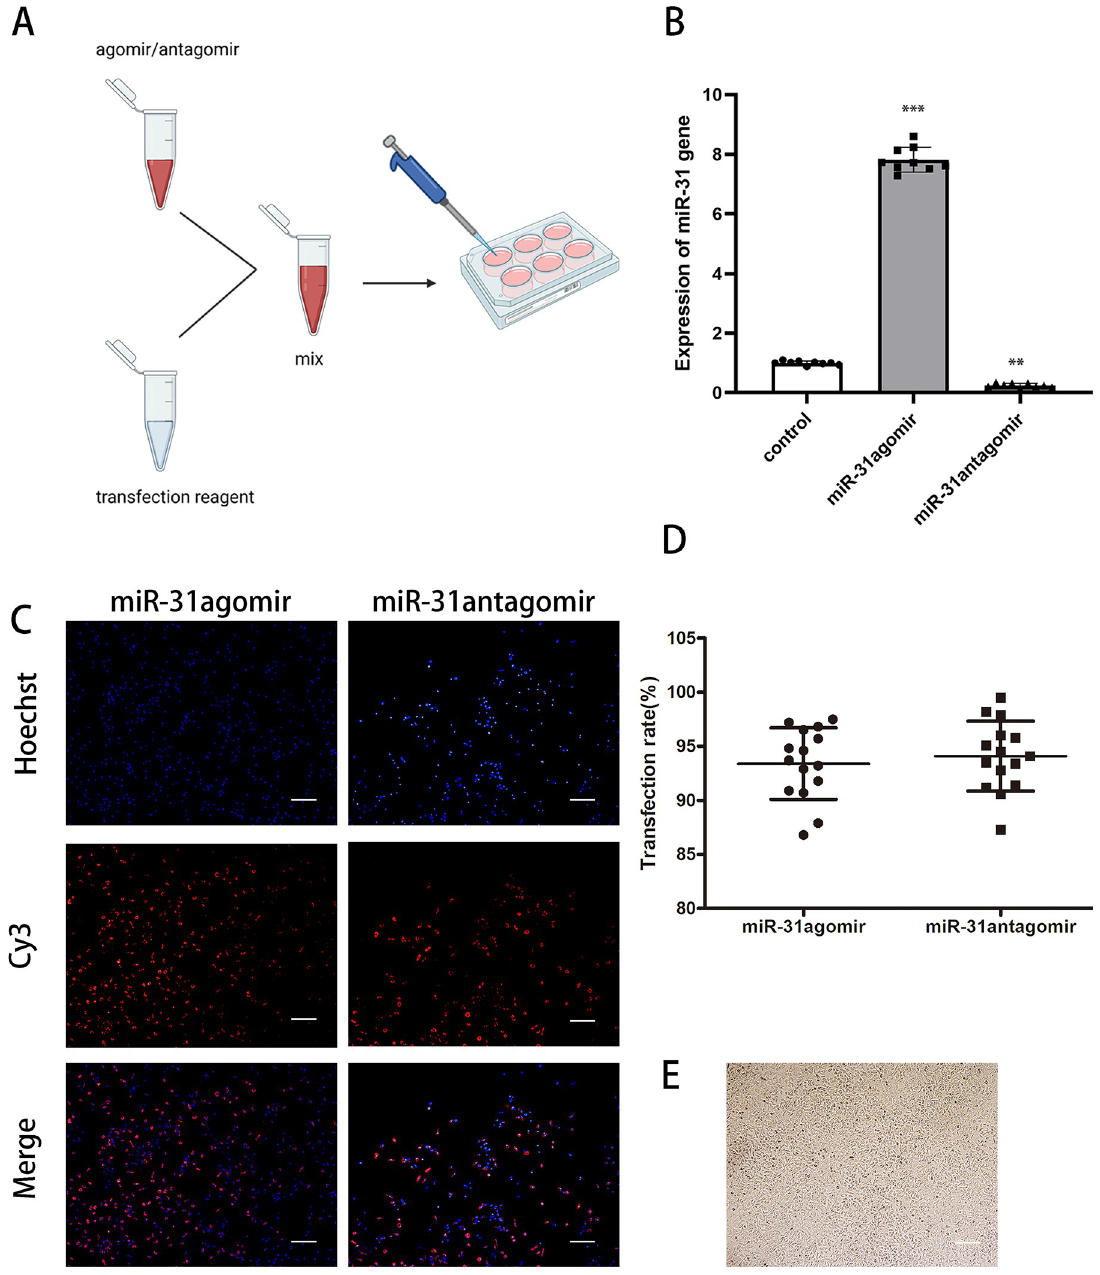
Fig 2. miR-31 transfection of BMSCs. A Schematic diagram of cell transfection. B Expression of miR-31 in bone marrow mesenchymal stem cells in each group after transfection was detected by qRT-PCR. C The status of miR-31 agomir and miR-31 antagomir transfection is detected by immunofluorescence, and successful transfection emits red fluorescence. Scar bar: 100 μ m. D Statistics of the results of miR- 31 agomir and miR-31 antagomir transfection efficiency. E Morphology of the cells under optical microscopy after transfection. Scar bar: 100 μ m. Dates are presented as mean ± SD (n = 9,15). Statistical analysis: compared to control, �� P < 0.01, ��� P < 0.001. results showed that the percentages of cells at the S phse in the miR-31 agomir group, miR- 31 antagomir group, and the control group were 22.45%, 16.85%, and 19.68%, respectively (Fig 3B). In summary, miR-31 can promote the proliferation of BMSCs.